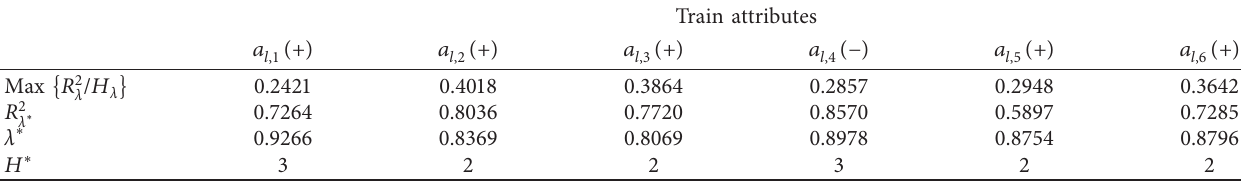
Table 6: The results of clustering hierarchy with different train attributes.